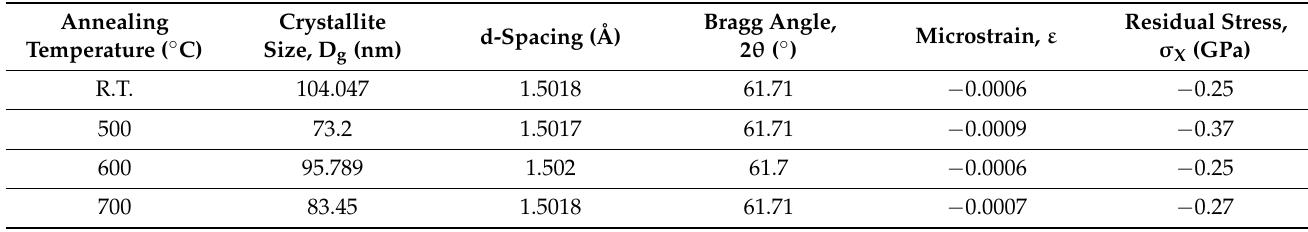
Table 3. The results of XRD at the <214> crystal